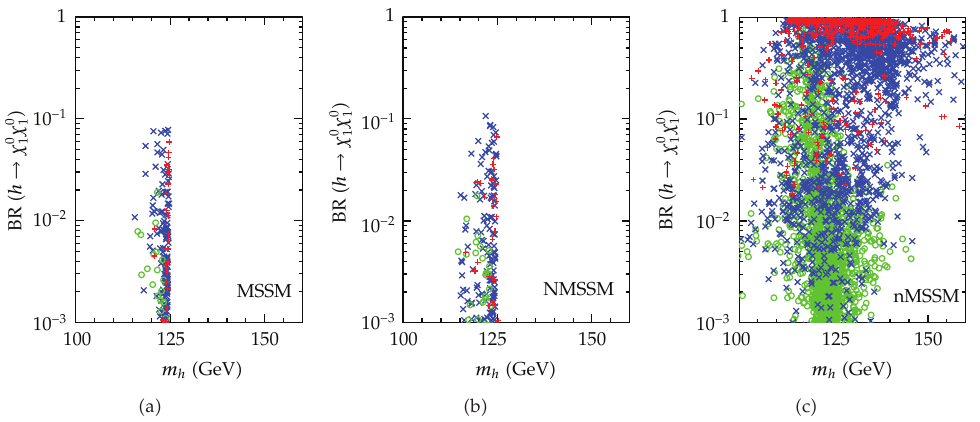
Figure 5: Same as Figure 1, but projected for the decay branching ratio of h SM → χ 0 the Higgs boson h SM (cid:2) taken for (cid:5) 46 (cid:6)(cid:3)